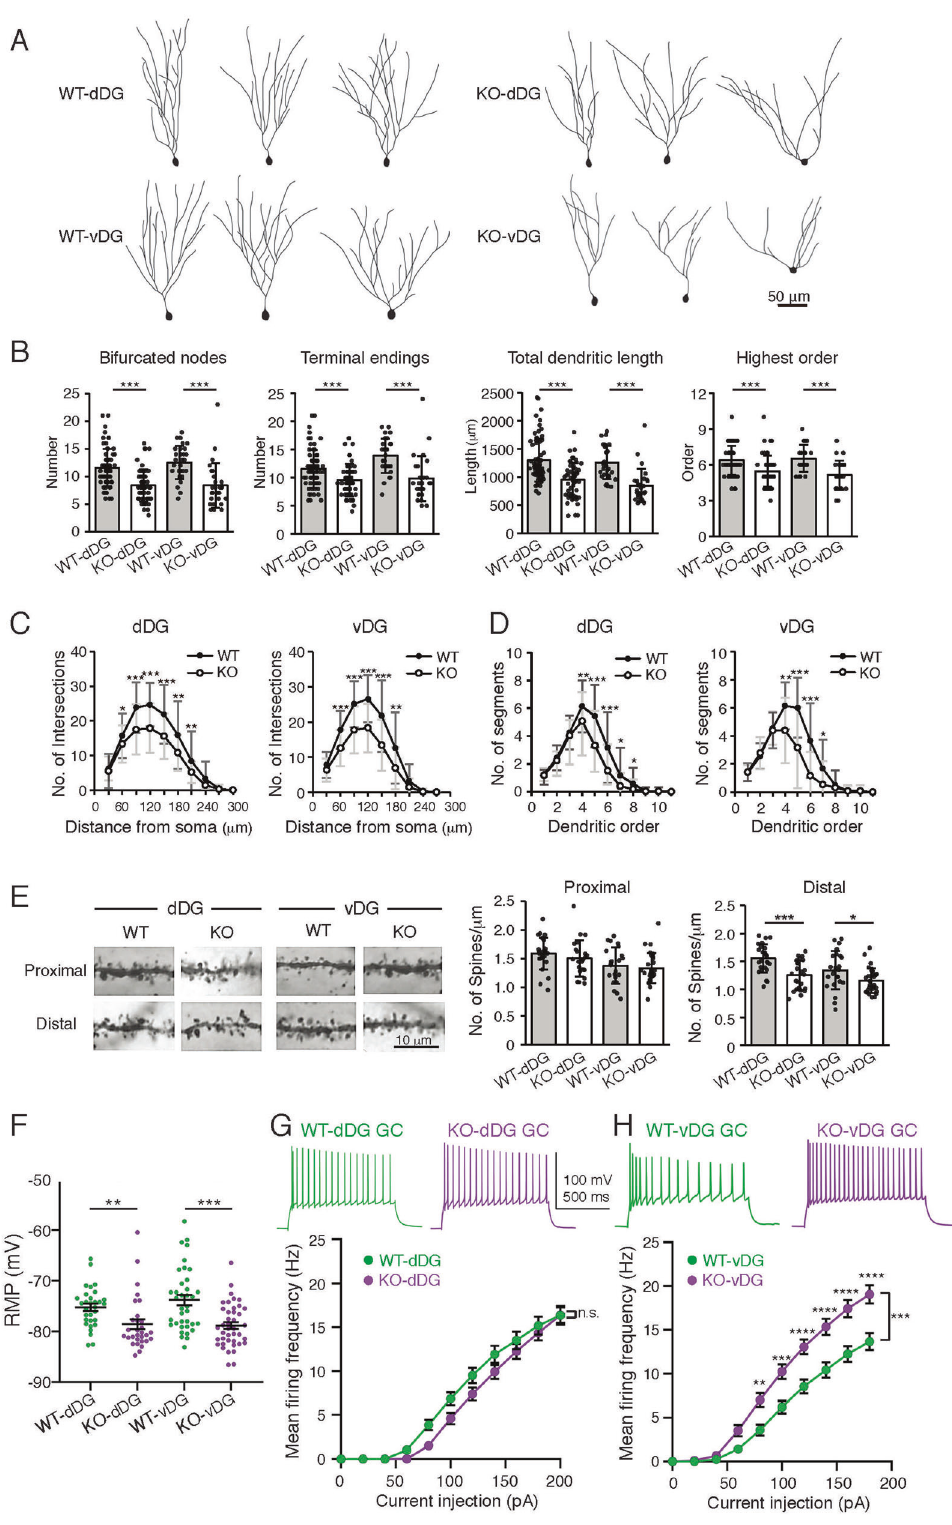
dDG by Golgi-Cox stain (Fig. 4A). The dendritic morphology, length complexity, and segmentations of the GCs were signi fi - cantly decreased in both vDG and dDG of the Blm-s − / − mice (Fig. 4B – D). The spine density was also signi fi cantly reduced on the distal dendrites of the Blm-s − / − GCs (Fig. 4E). These